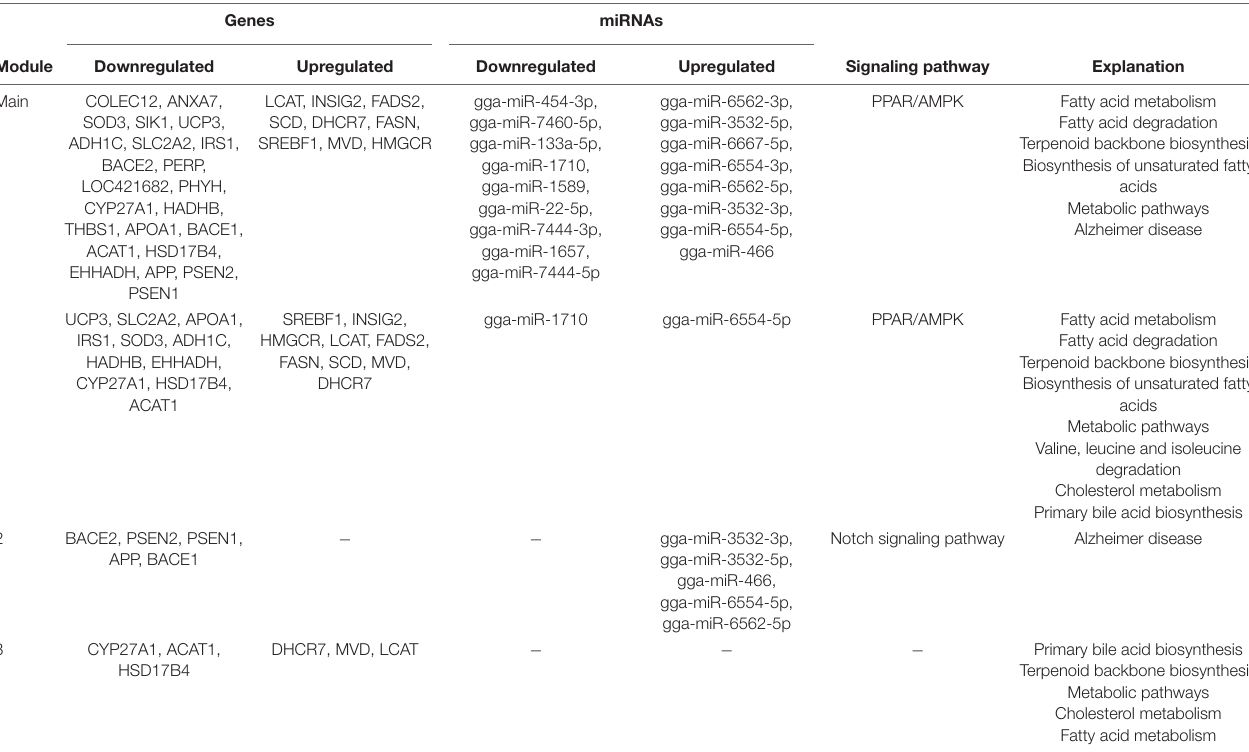
TABLE 3 | Main, modules, genes, miRNAs, signaling pathway, and phenotypic explanations in the integrated gene–miRNA bipartite network involved in fat metabolism and deposition. Genes miRNAs Module Upregulated Downregulated Upregulated Signaling pathway